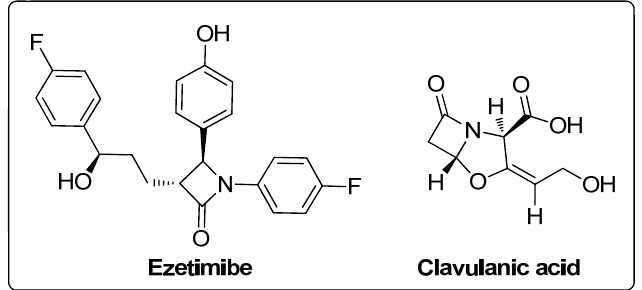
Figure 2. β‐ Lactam clinical drugs.